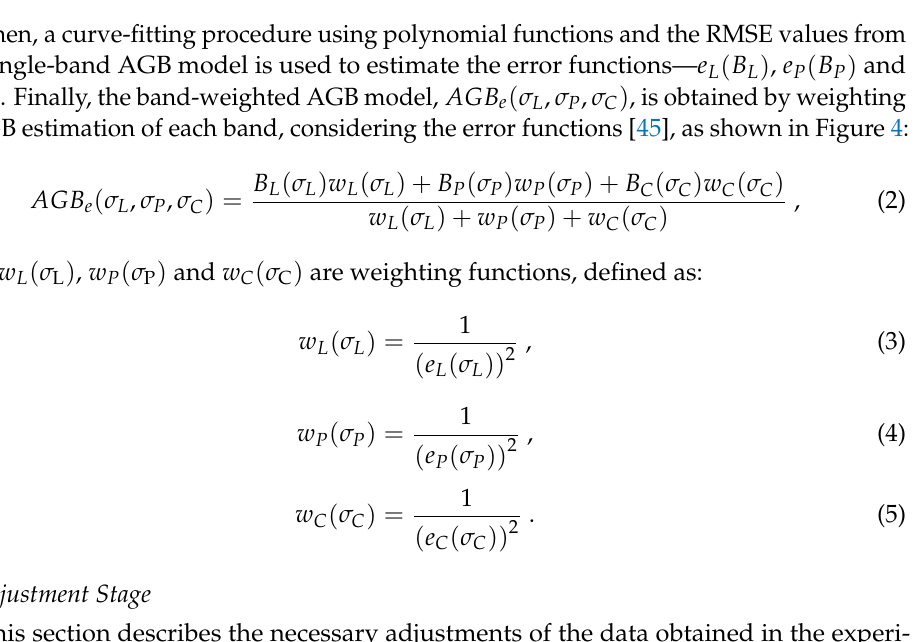
Table 3. Root-mean-square error (RMSE) evaluation of single-band AGB models in different ranges of AGB. Range 1: Range 2: Band [0 to 4 kg m − 2 ] [4 to 11 kg m − 2 ]